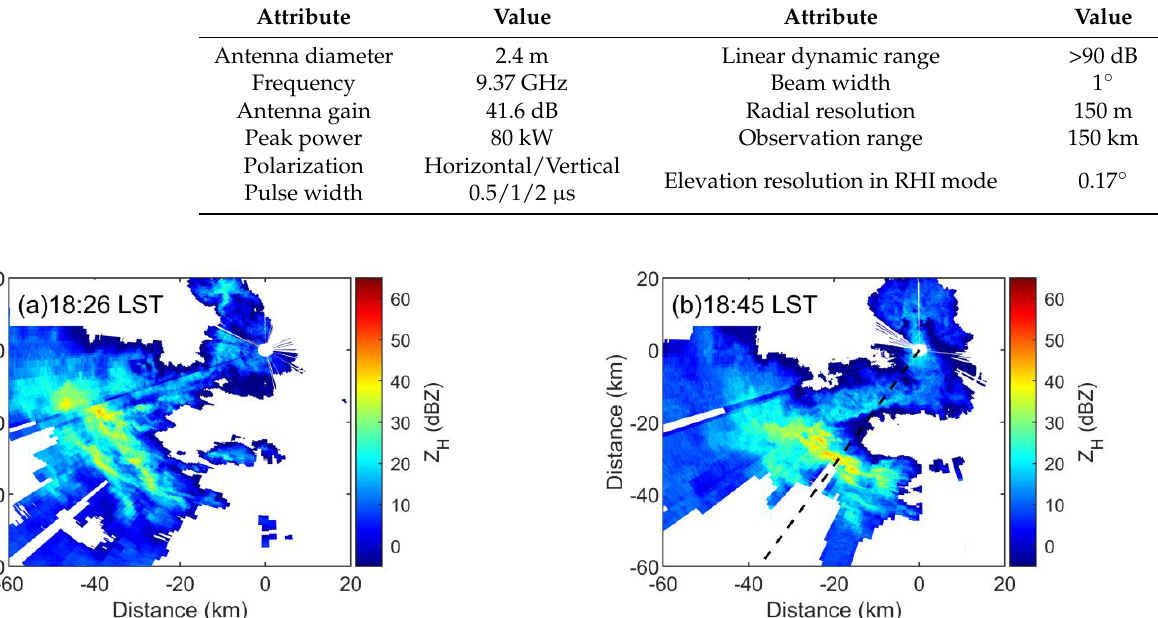
Figure 8. Sample PPI observations of Z H . (The elevation of the PPI is 4°. The azimuth of the dashed line in Figure 8b is 212 ◦ . The data collection time is 7 September 2016). ( a ) 18:26 LST, ( b ) 18:45 LST.